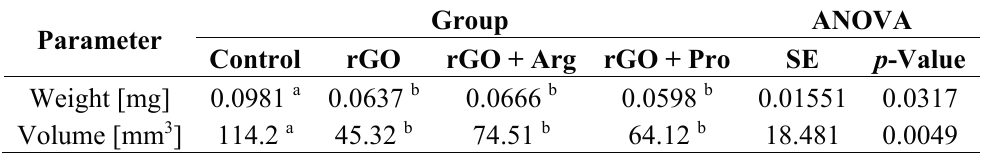
Table 1. Characteristics of glioblastoma multiforme U87 tumors cultured on chicken embryo chorioallantoic membrane after treatment with reduced graphene oxide, reduced graphene oxide with arginine and reduced graphene oxide with proline or untreated as a